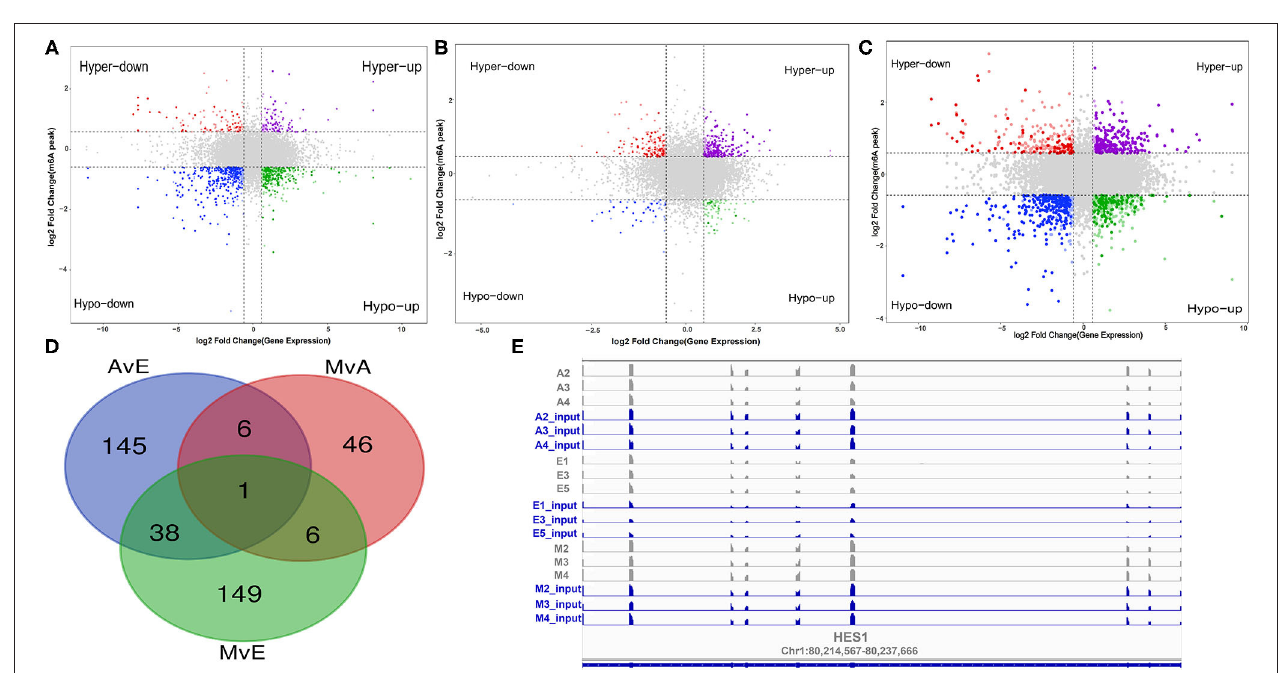
FIGURE 5 | A conjoint analysis of methylated RNA immunoprecipitation sequencing (MeRIP-Seq) and RNA sequencing (RNA-Seq) data. (A–C) Distribution of genes with a significant change in both the m6A methylation level and gene expression in each group. (D) Venn diagram showed the negative correlation of m6A-modified genes in each group. (E) m6A enrichment and gene expression profile of HES1 in the three stages.